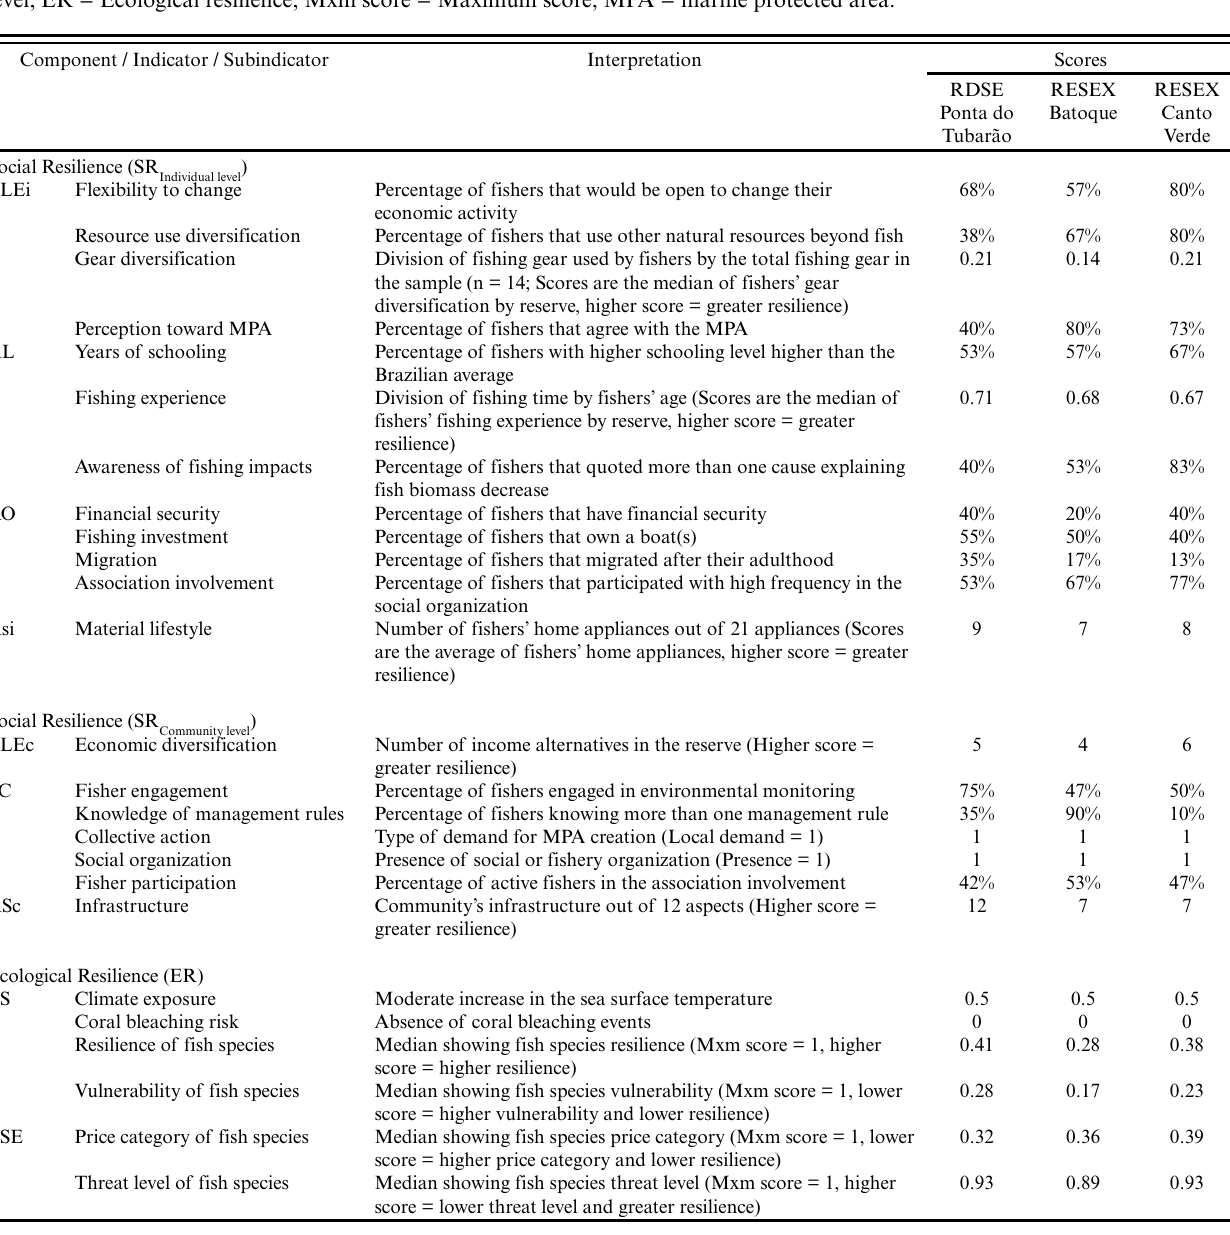
Table 4 . Social-ecological resilience index (SERI) indicator interpretation and scores for the three studied reserves: RDSE Ponta do Tubarão, RESEX Batoque, and RESEX Canto Verde. SRi = Social resilience at individual level; SRc = Social resilience at community level; ER = Ecological resilience; Mxm score = Maximum score; MPA = marine protected